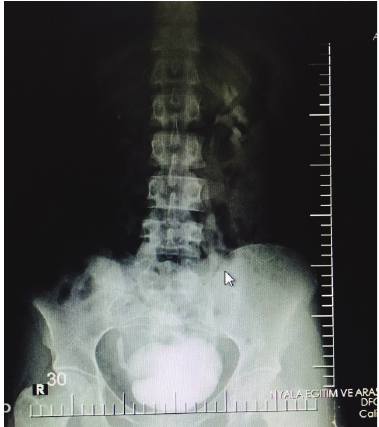
Figure 2: Intravenous pyelography image of urinary system.